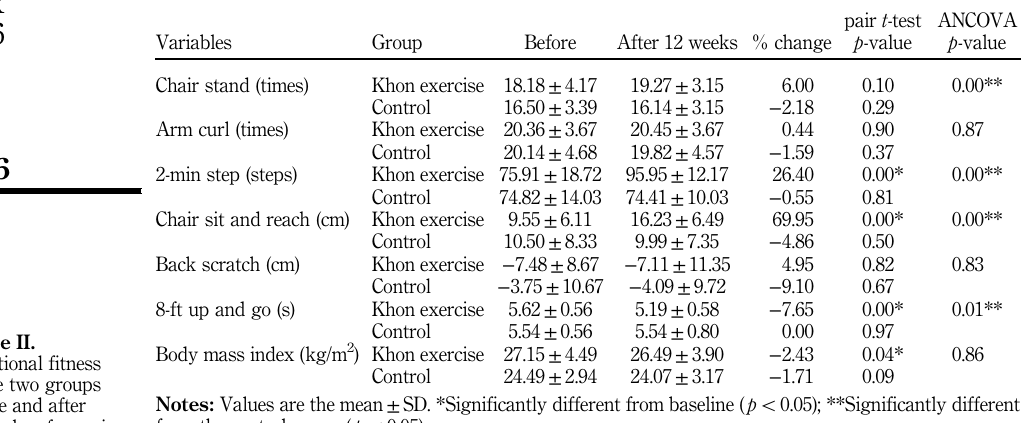
Table II. Functional fitness of the two groups before and after 12 weeks of